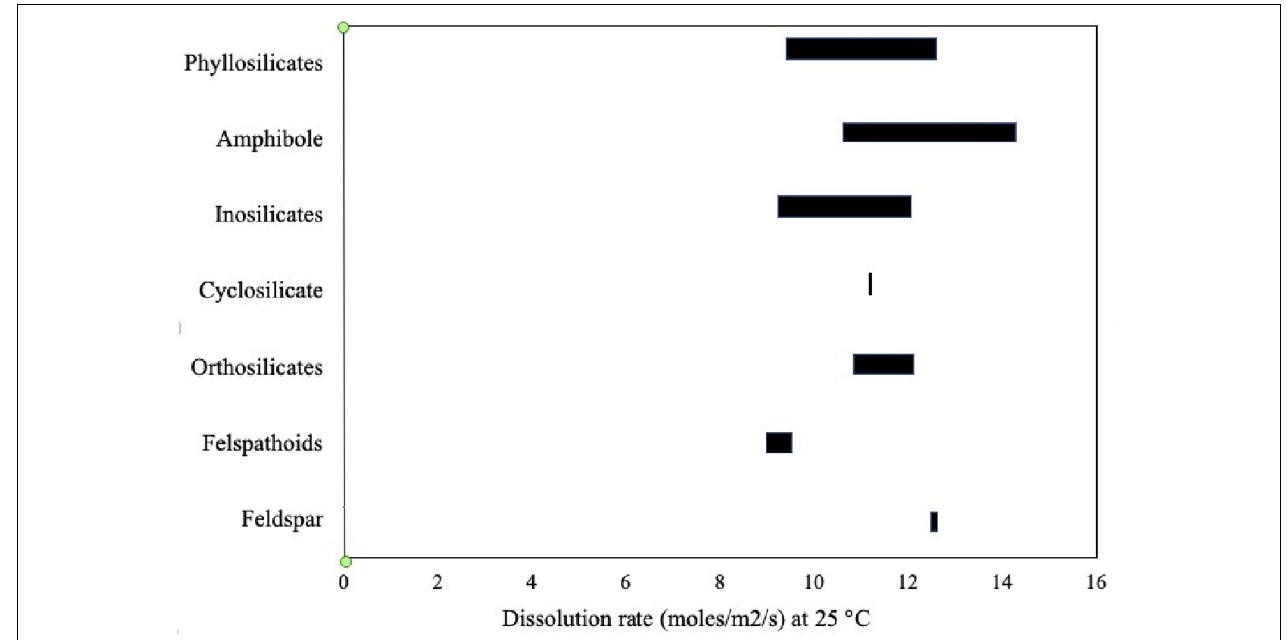
FIGURE 1 | Dissolution rates for major rock-forming minerals at 25 ◦ C and pH 5.1–7.7 (Palandri and Kharaka,